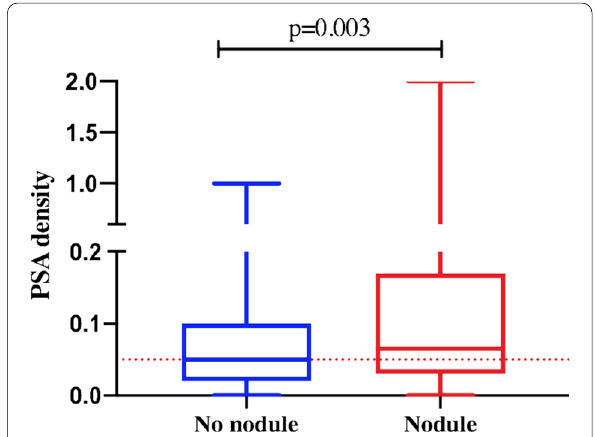
Fig. 6 Box and whisker plot demonstrating participants’ PSA density for those with nodules and those